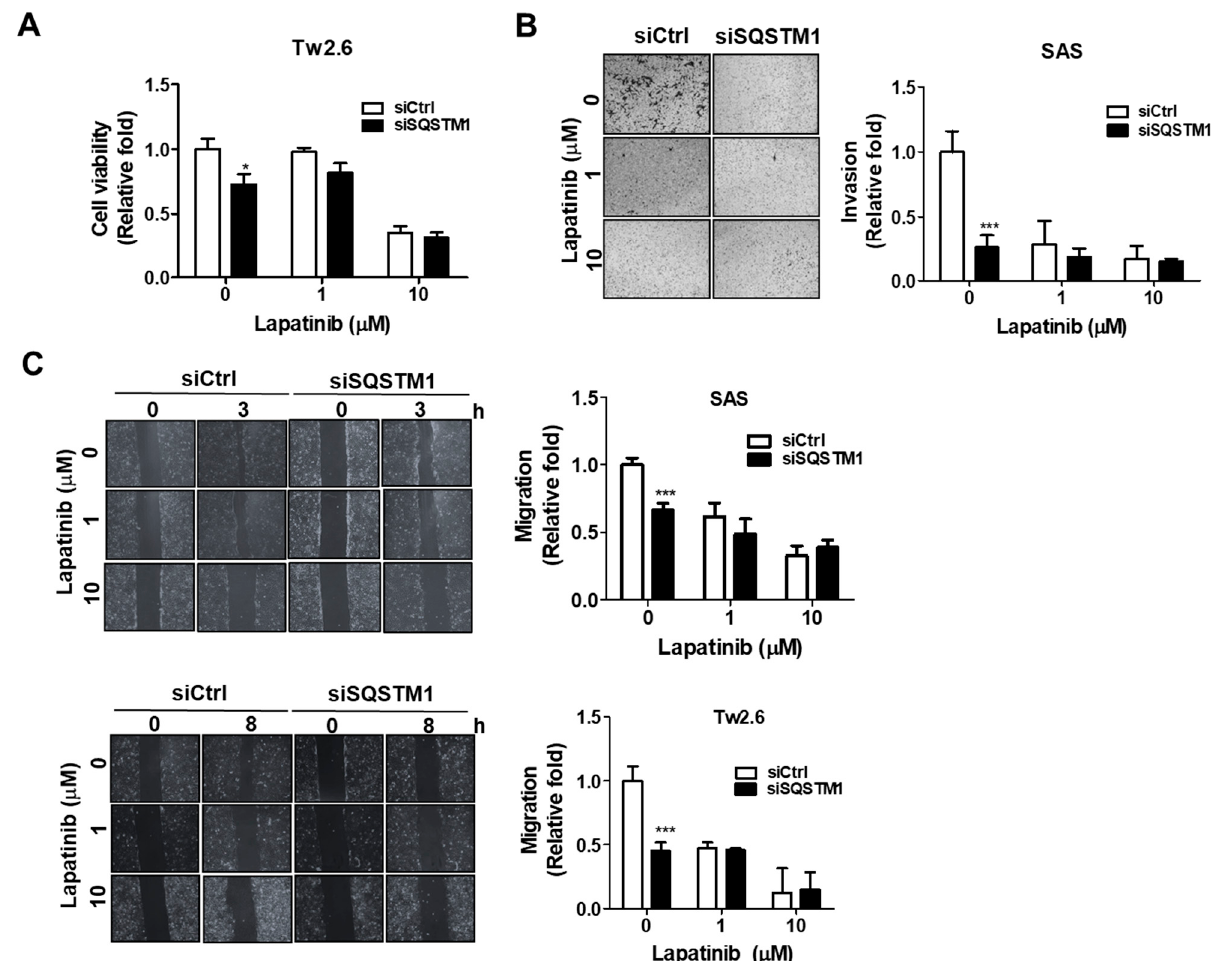
Figure 2. Effects of EGFR inhibitors on cell malignancy in SQSTM1-silenced OSCC cells. ( A ) Cell viability of TW2.6 cells silenced by siRNA against SQSTM1 for 48 h, then treated with Lapatinib (0–10 µ M) for 24 h, measured with the CellTiter-Glo luminescent cell viability assay. ( B ) Invasion of SAS cells silenced by siRNA against SQSTM1 for 48 h, then treated with Lapatinib (0–10 μ M) for 24 h, measured using the transwell invasion assay. ( C ) Migration of SAS and TW2.6 cells silenced by siRNA against SQSTM1 for 48 h, then treated with Lapatinib (0–10 μ M) for 24 h, measured with the wound-healing assay. The mean ± SEM from three independent experiments was calculated. A two-sided p -value less than 0.05 was considered statistically significant (* p < 0.05; *** p < 0.001).